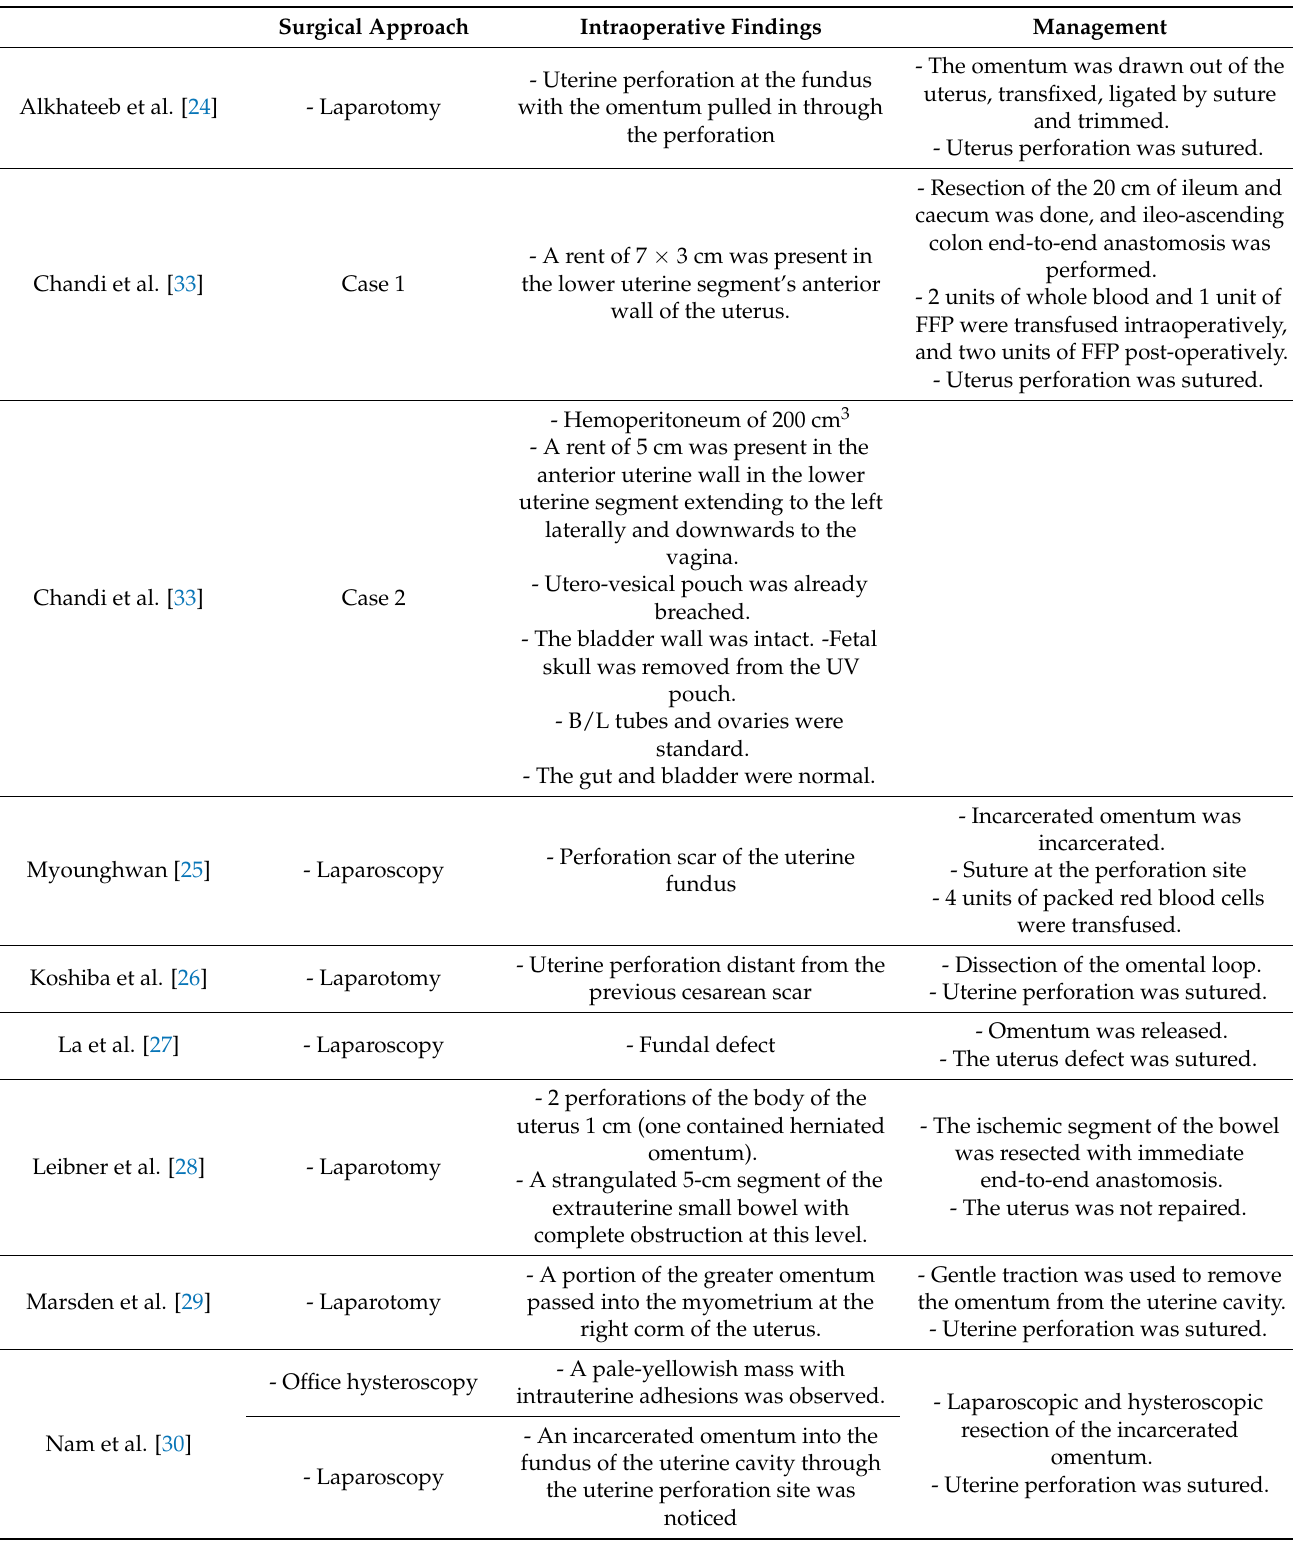
Table 3. Applied surgical approach, intraoperative findings and